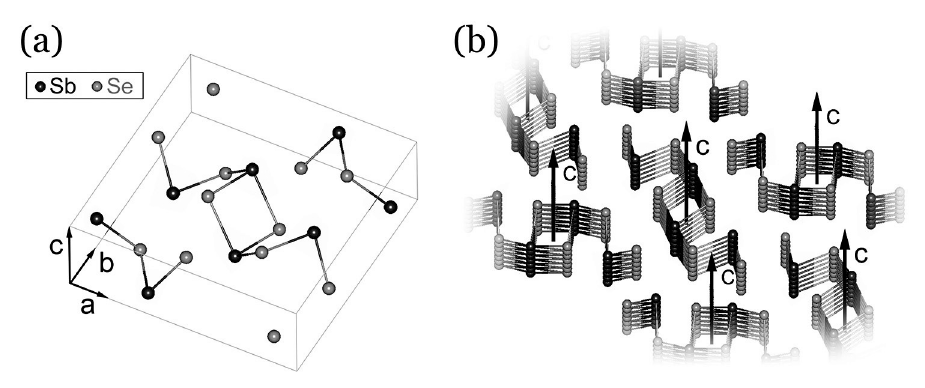
Fig. 1. – Crystal structure of Sb 2 Se 3 is characterized by an orthorombic cell in the Pbnm space group: (a) unit cell; (b) (Sb 4 Se 6 ) ribbons visualization, here obtained by the stacking of n = 6 planes along the c